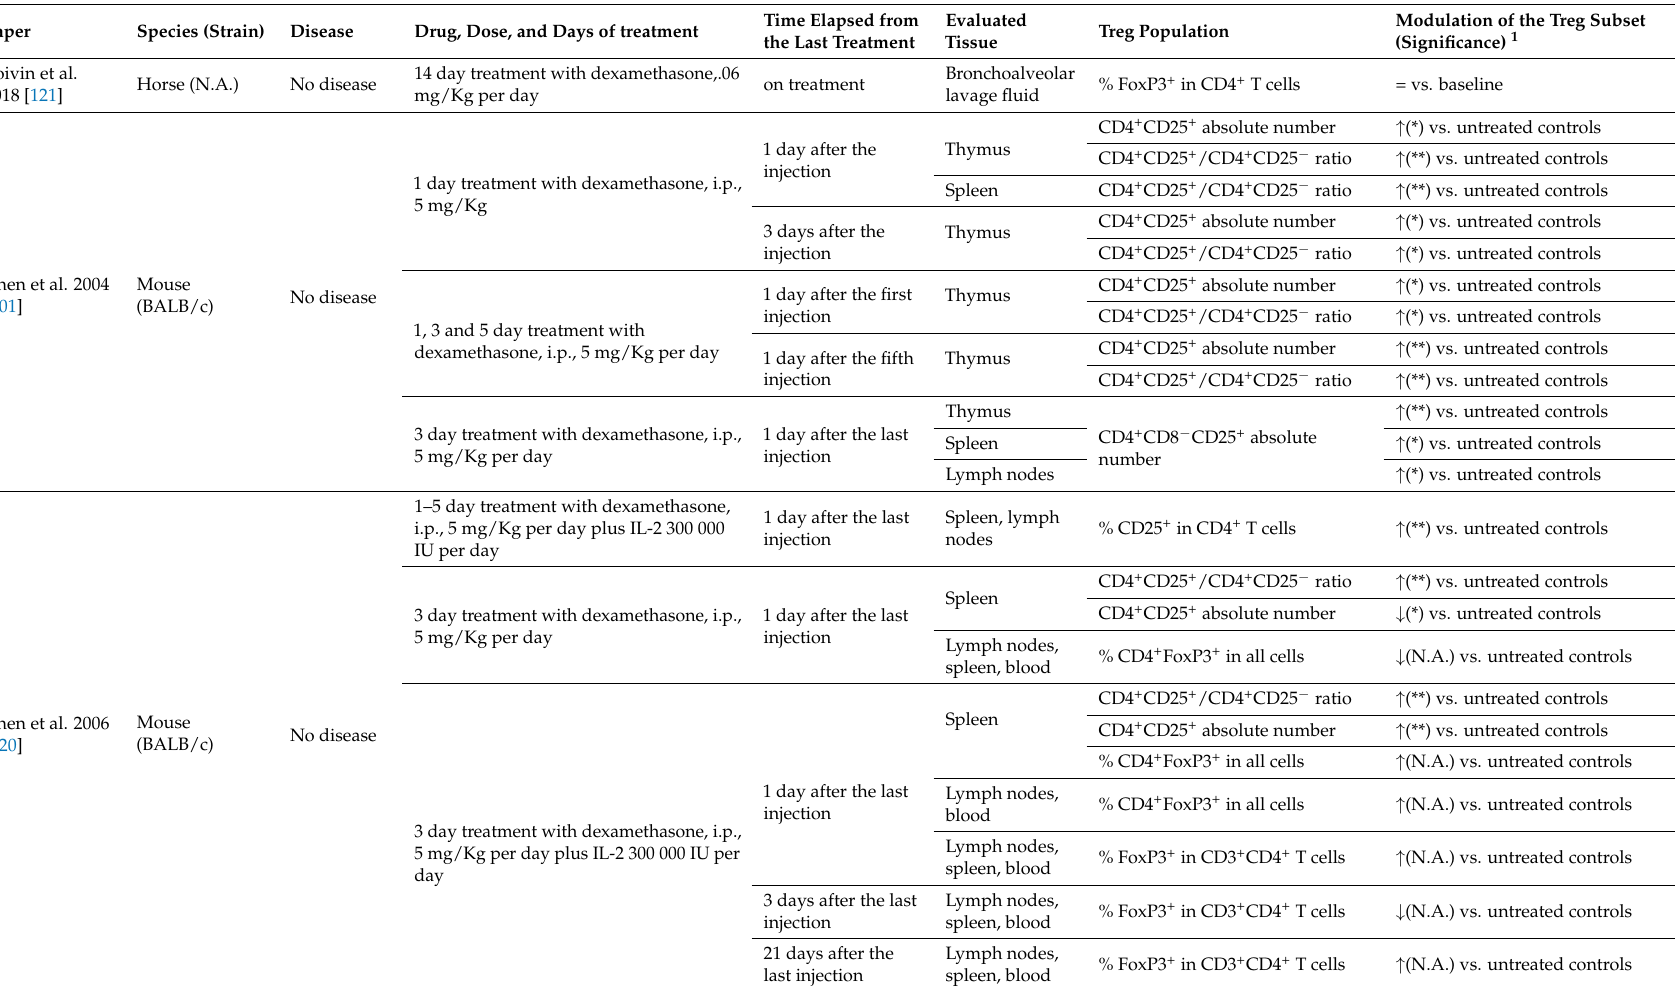
Table 1. Modulation of regulatory T (Treg) cell subsets following GC treatment in healthy animals and disease